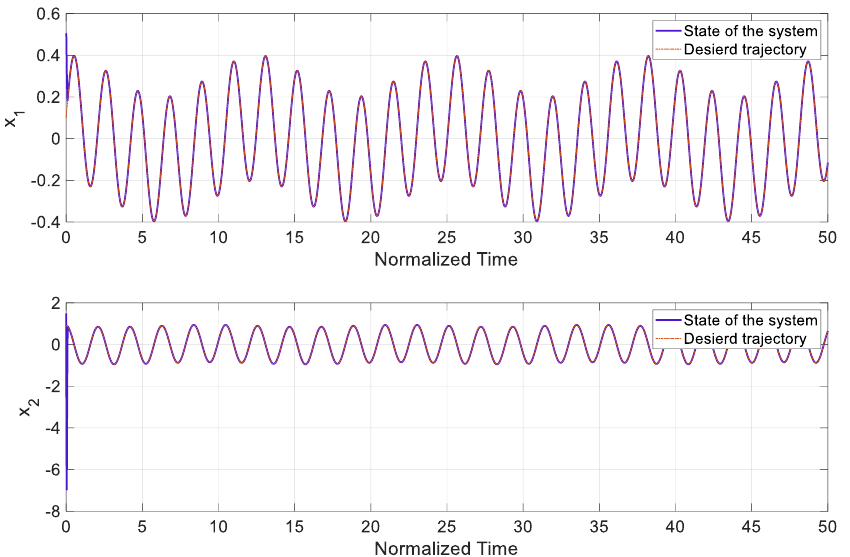
Figure 8. The states of CNT in tracking control in the presence of uncertain parameters and un- known disturbance.